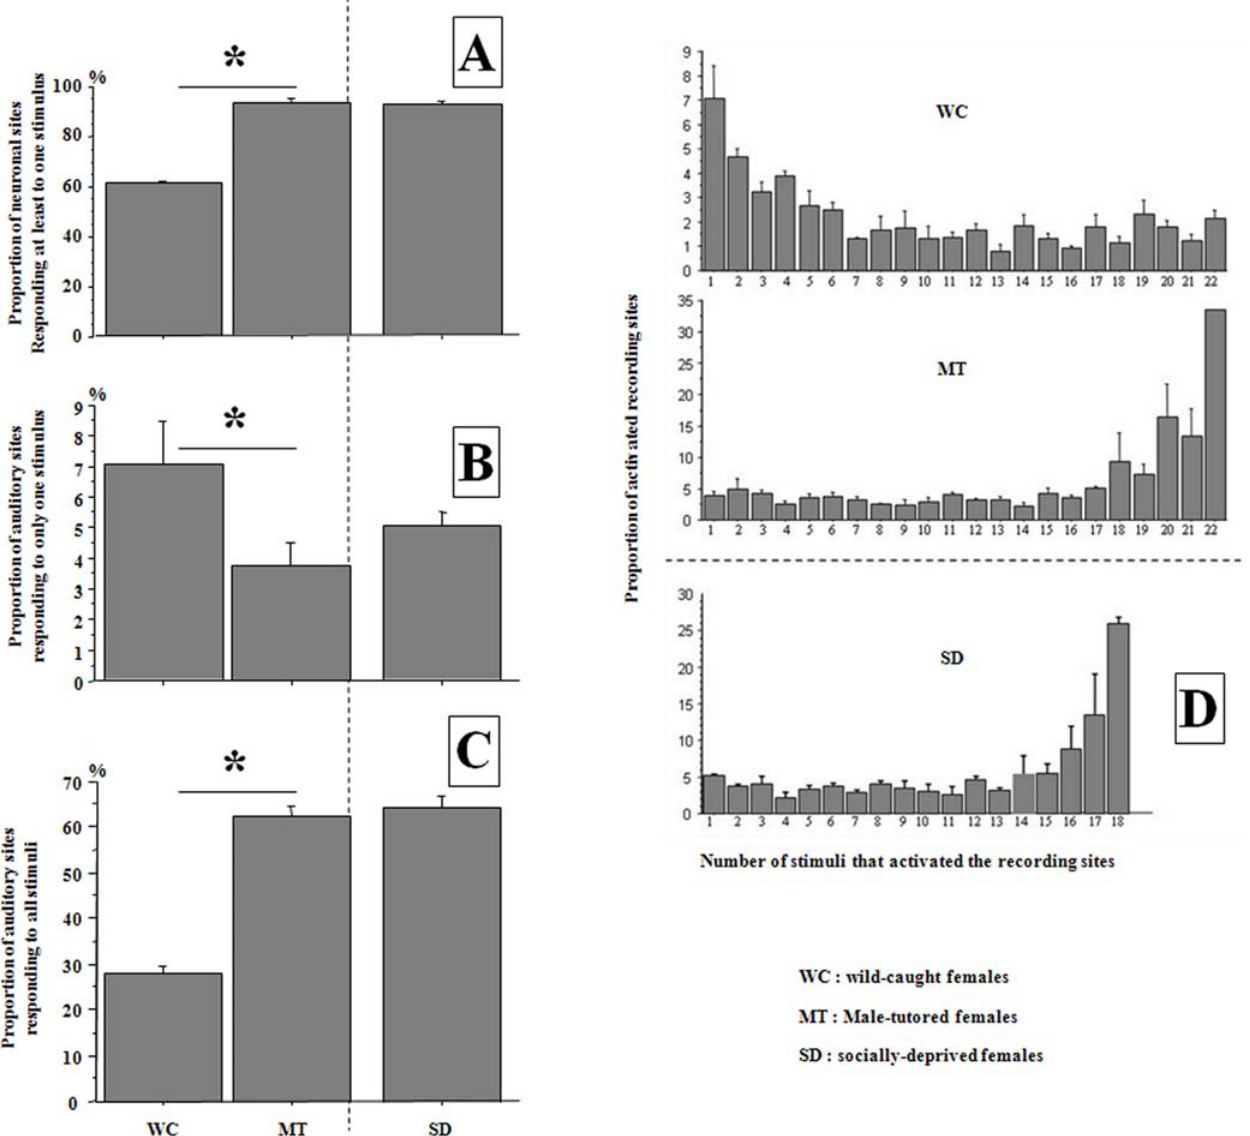
Figure 1. - A - Proportion of neuronal sites responding to at least one stimulus. The difference between wild-caught females ( WC ~ 61 : 23 % + 0 : 64 ) and male-tutored females ( MT ~ 93 : 29 % + 1 : 31 ) was significant (Mann-Whitney, U=0, p=0.05), but the proportion did not differ significantly between male-tutored and socially-deprived females ( SD ~ 92 : 52 + 0 : 87 ). - B & C - Proportion of sites that responded to only one stimulus ( B ) and to all stimuli ( C ). These values were obtained using 6 class I whistles that were common to all birds. The difference between wild-caught and male- tutored females was significant in both cases ( B- MT ~ 3 : 77 + 0 : 75 , WC ~ 7 : 03 + 1 : 39 ; Mann-Whitney, U=0, p=0.05 and C- MT ~ 62 : 44 + 2 : 23 , WC ~ 27 : 9 + 1 : 59 , U=0, p=0.05). Results for male-tutored females and for socially deprived birds did not differ significantly. - D - Proportion of neuronal sites responding to the 1, 2..or all stimuli used. A majority of neuronal sites responded to 1 to 4 stimuli in the wild-caught females (WC), whereas most neuronal sites responded to all or most stimuli in the male-tutored (MT) as well as in the socially-deprived birds